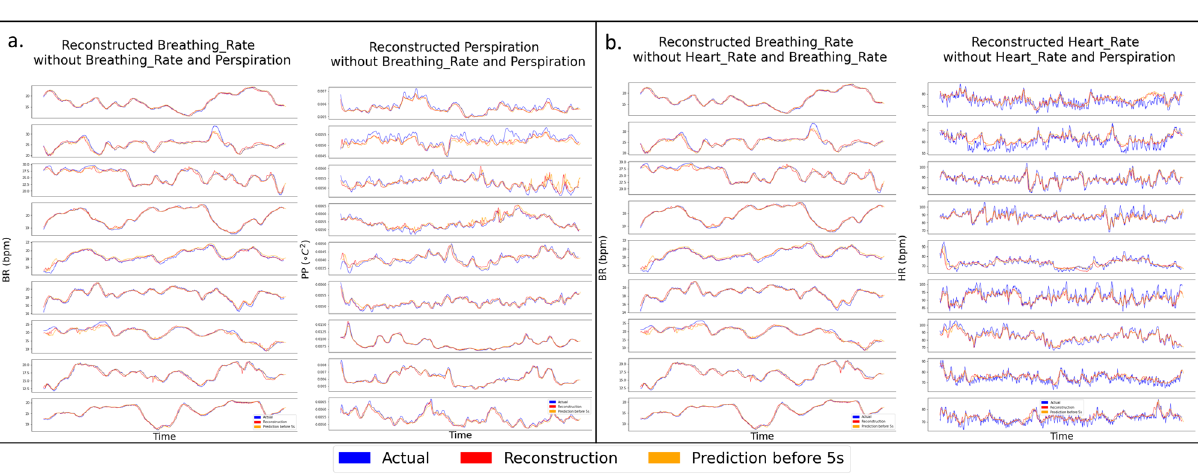
Figure 3. Estimations for missing modalities based on other modalities for all nine testing sessions.